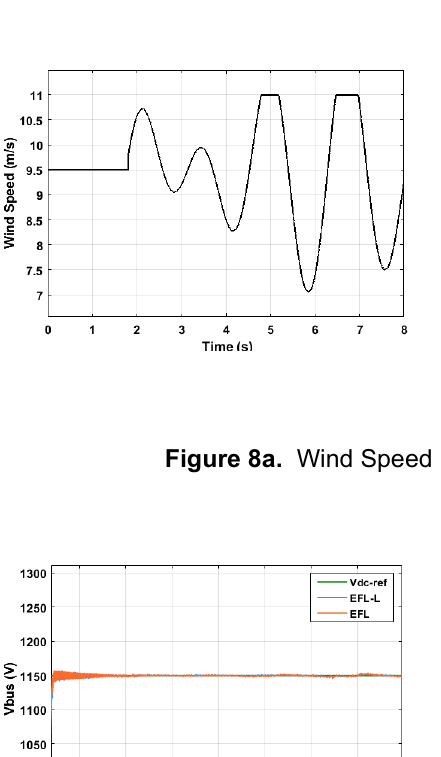
Figure 7b. Reactive Power